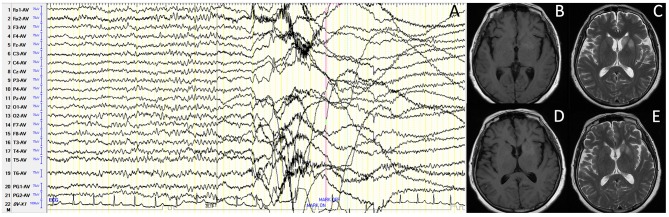
Case 9, female, 63 years old, who was diagnosed with leucine-rich glioma-inactivated 1 protein (LGI1) antibody-associated autoimmune encephalitis (AE). (A) Ictal electroencephalogram (EEG) of faciobranchial dystonia seizure (FBDS) showed that 1 s before the clinical onset, the amplitude of all the leads suppressed, followed by artifact of movements, which continued for 5 s, and then recovered to background. (B,C) Nineteen days after onset and before immunotherapy, brain MRI showed high T1/T2 signal on the left basal ganglia (caudal nucleus and lenticular nucleus). (D,E) Thirty-three days after onset (10 days after immunotherapy), brain MRI showed significant improvement in the high T1/T2 signal on the left basal ganglia.